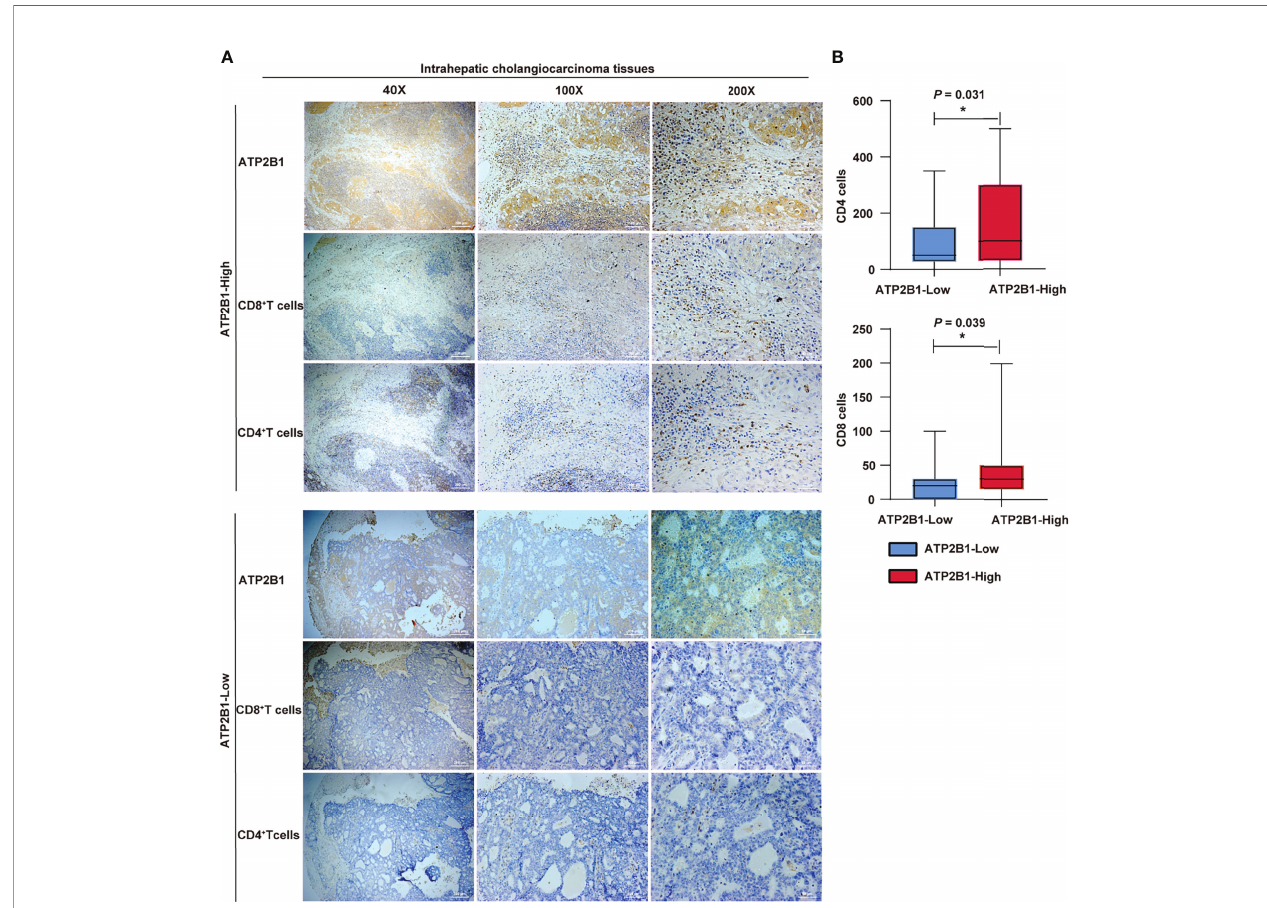
FIGURE 6 | ATP2B1 expression in CD4 + and CD8 + immune cells. (A) IHC staining analysis of CD4 + and CD8 + immune cells; (B) Numbers of CD4 + and CD8 + cells detected by IHC. * P < 0.05; ** P < 0.01; *** P <